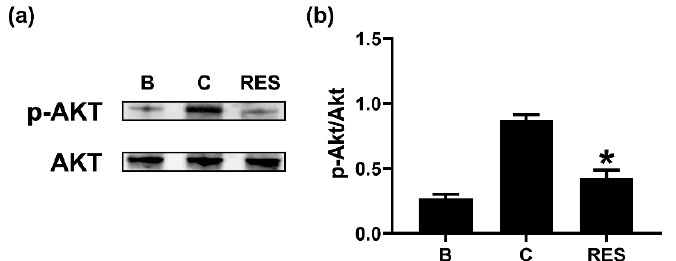
Figure 5. Effects of RES on the phosphorylation of Akt in neutrophil-like dHL-60 cells. ( a ) dHL-60 cells (5 × 10 6 ) were exposed to RES (3 µM) for 1h, and then stimulated with GM-CSF (5 ng/mL) for 30 min. ( b ) The protein levels were quantitated by densitometry. B, PBS-added and unstimulated cells; C, PBS-added and GM-CSF-stimulated cells; RES, RES-added and GM-CSF-stimulated cells. Data are shown as the mean ± SEM of three independent experiments. * p < 0.05 vs. the PBS-added and GM-CSF-stimulated cells.